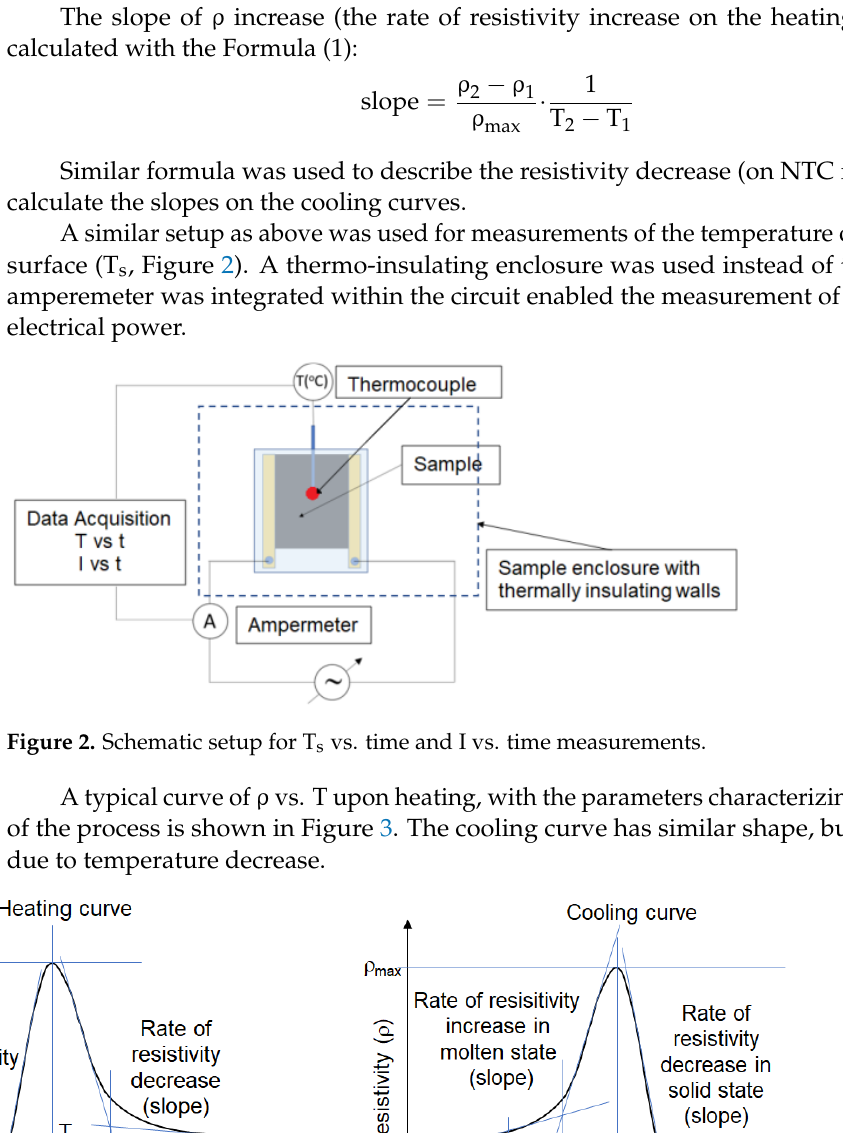
Figure 1. Schematic setup for  -T measurements.